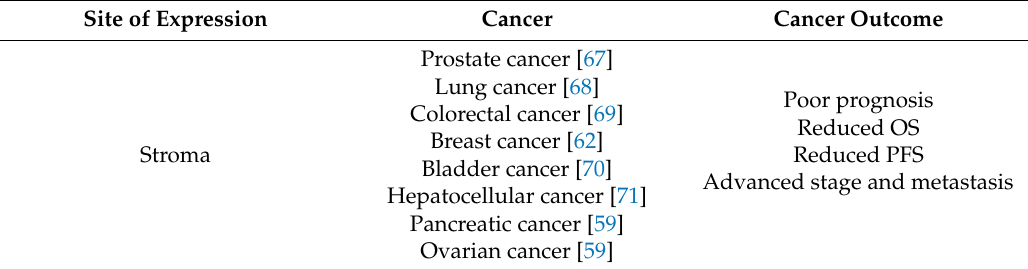
Table 4. Periostin overexpression and cancer